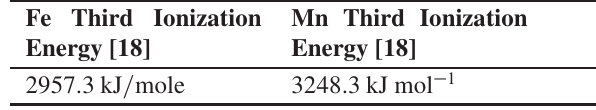
Table 2. Third Ionization Energies of Iron and